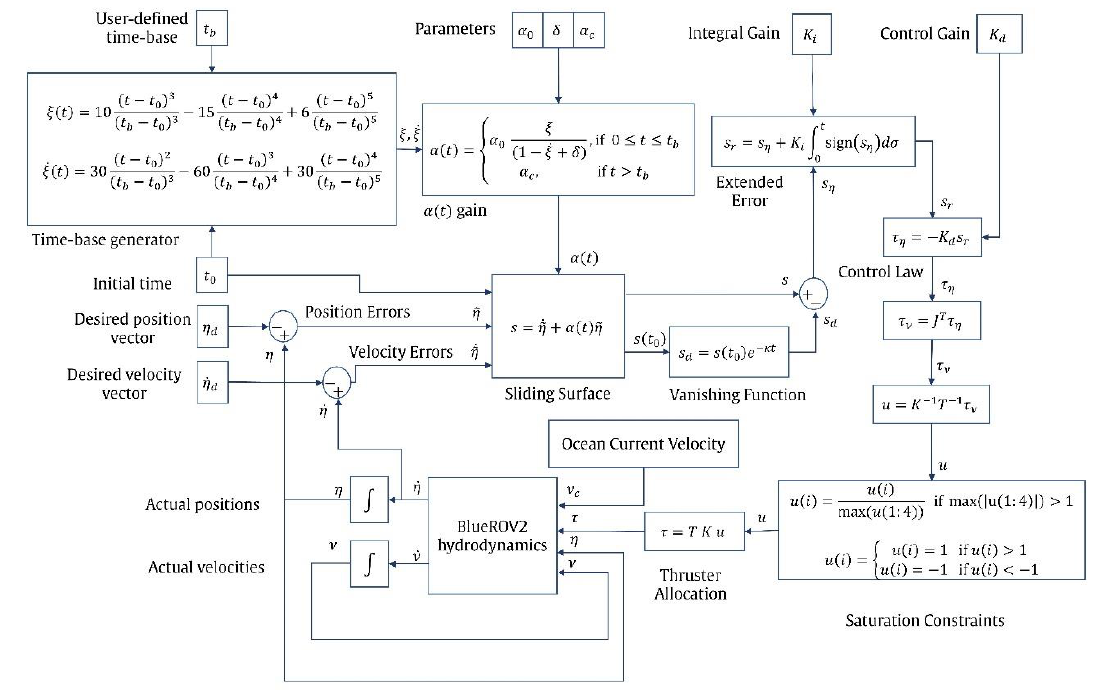
Figure 2. Model-free second-order sliding mode control with finite-time convergence complete block diagram.